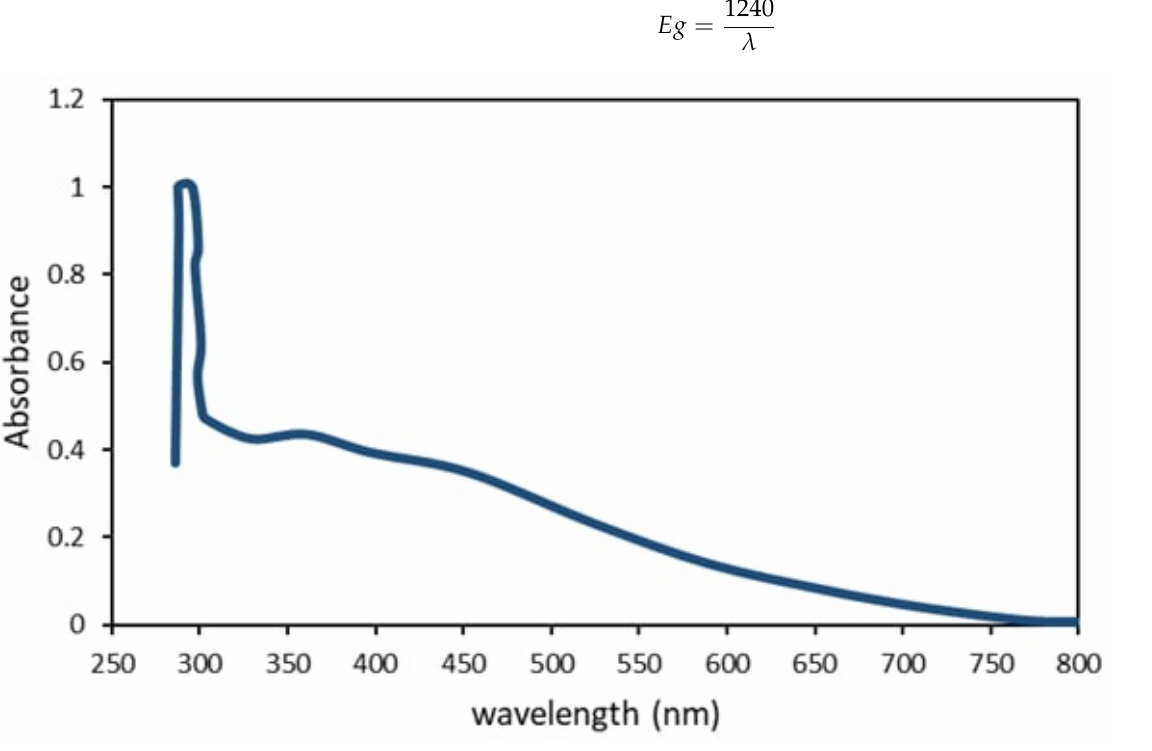
Figure 10. Absorption spectrum of TiO 2 . Figure 11 shows that the TiO 2 film that was poured on the FTO glass allows the trans- mission of visible light and absorbs ultraviolet rays. The average visible light transmission of TiO 2 after casting on the FTO substrate reduced to about 74.34%. However, coated FTO allows maximum transmission of visible light to the dye (sensitive material) for optimal absorption and conversion to electricity in DSSCs, while blocking harmful UV rays.